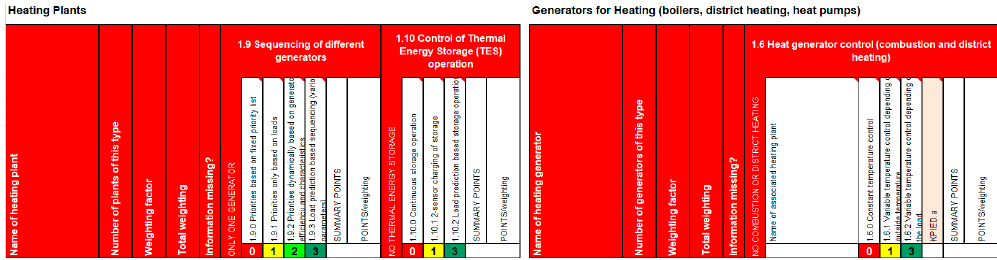
Figure 1. Caption of some services associated with the heating system domain in eu.bac system [26].